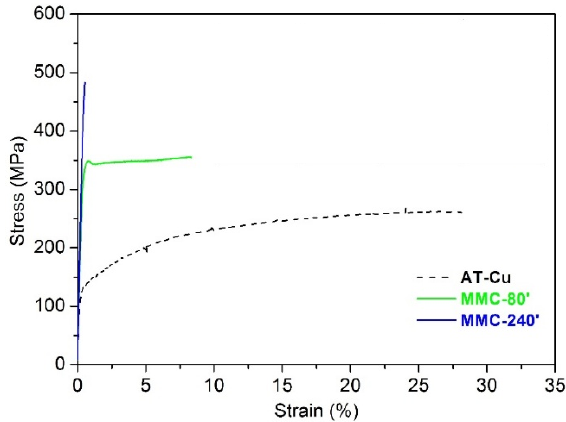
Figure 10. Tensile stress ‐ strain curves of the sintered mechanical alloying (MA) samples and AT ‐ Cu.